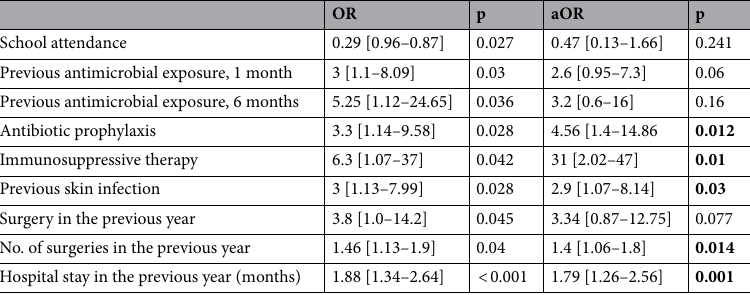
Table 3. Univariate and multivariate analysis of risk factors associated with multidrug-resistant Gram- negative bacilli colonisation. Significant values are given in bold.